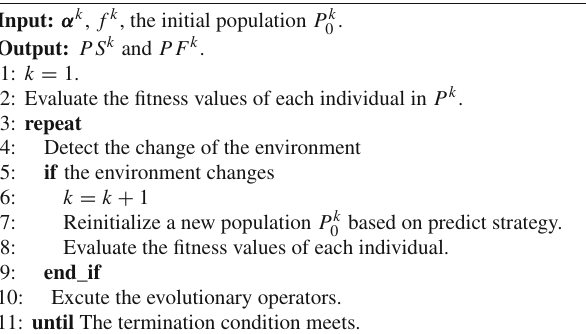
Algorithm 1 TMO-based dynamic multi-objective optimiza- tion